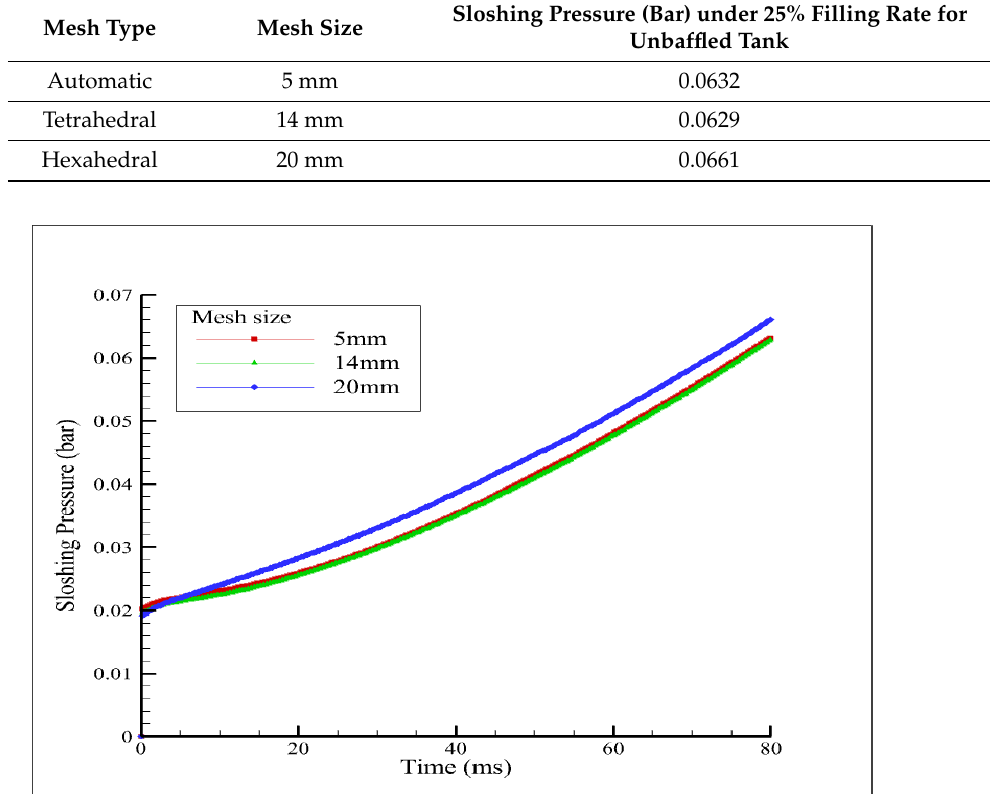
Figure 8. Comparison of mesh sensitivity effect on sloshing pressure in unbaffled rectangular tank under 25% filling